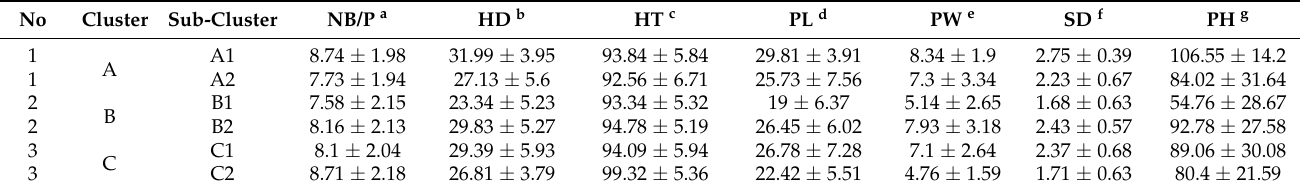
Table 4. Differences in agronomic traits within each subcluster